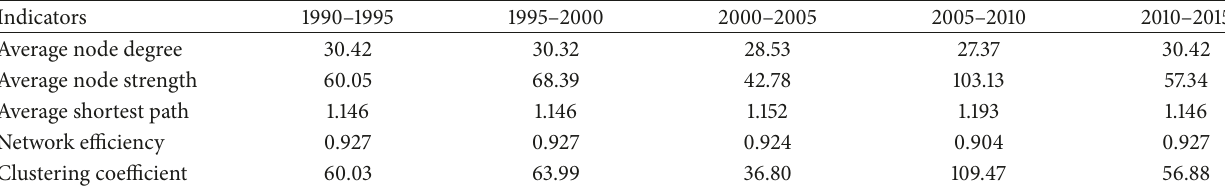
Figure 3: The topology of land system networks showing the conversions among land cover types in 2010–2015. Table 2: Topological indicators of the directed weighted land system